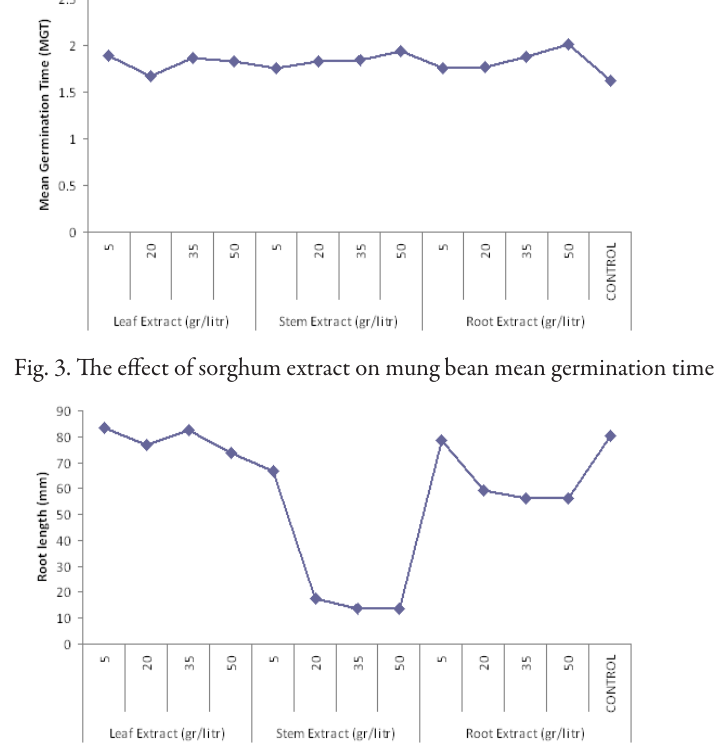
Fig. 4. The effect of sorghum extract on mung bean